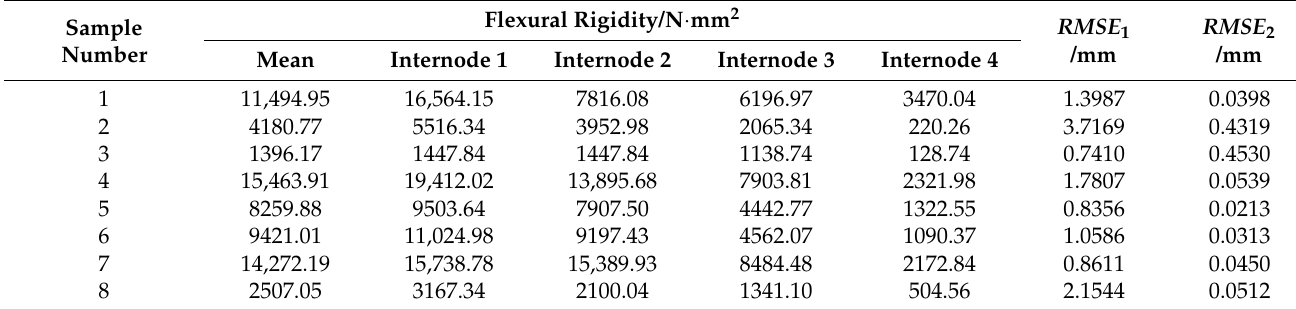
Table 1. Flexural rigidity of tea stalks and RMSE values of deflection